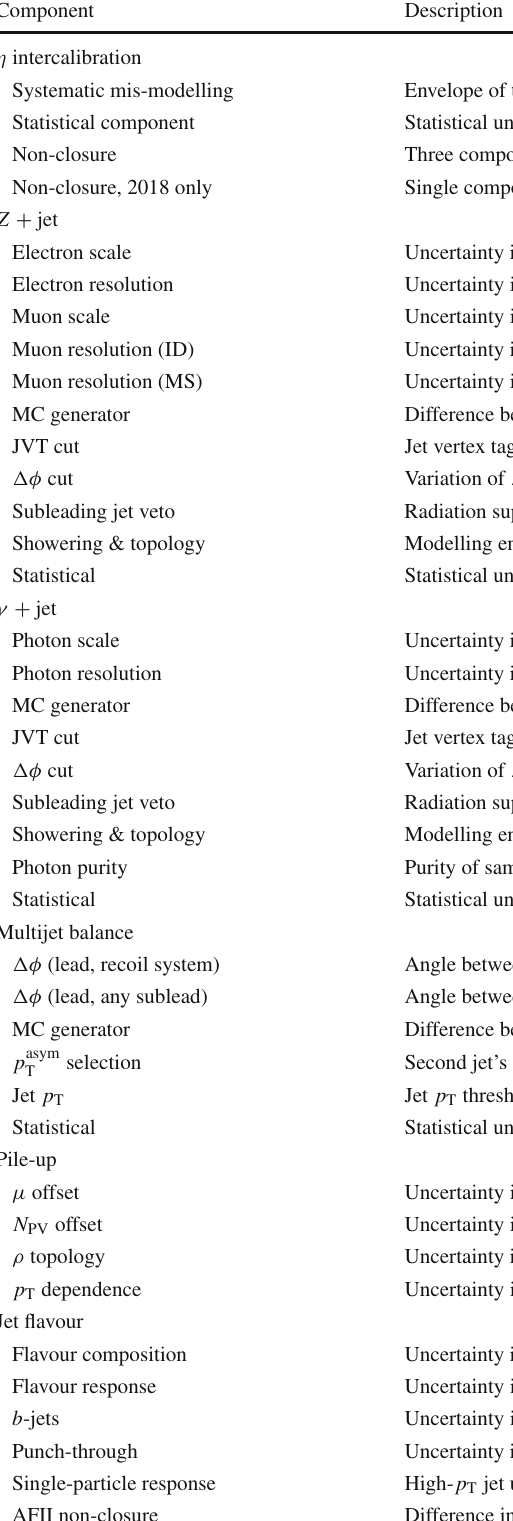
Table 2 Sources of uncertainty in the jet energy scale